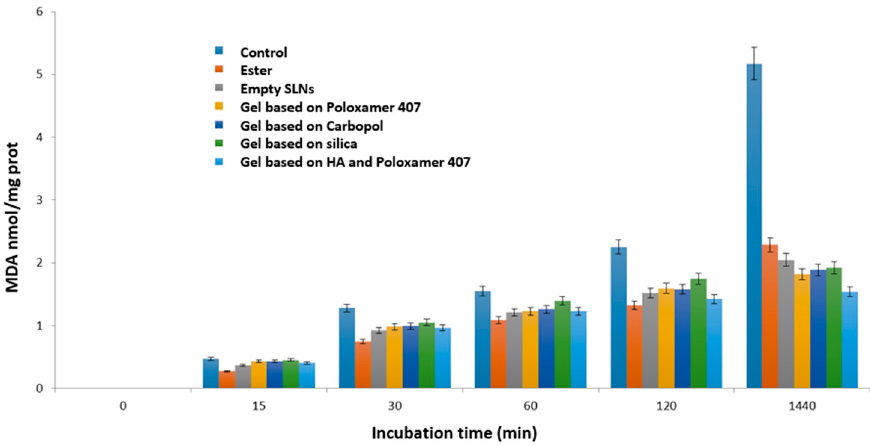
Figure 12. Inhibition of lipid peroxidation induced by tert -BOOH over 24